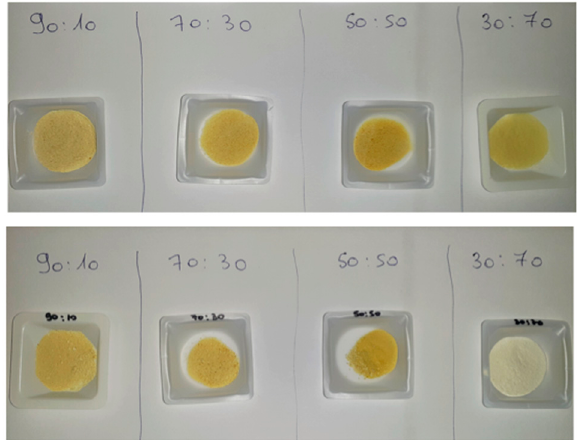
Figure 3. Visual appearance of different SilverSil xerogels prior ( top ) and after TCA dehalogenation reaction with NaBH 4 as reducing agent in 6:1 molar ratio ( bottom ).